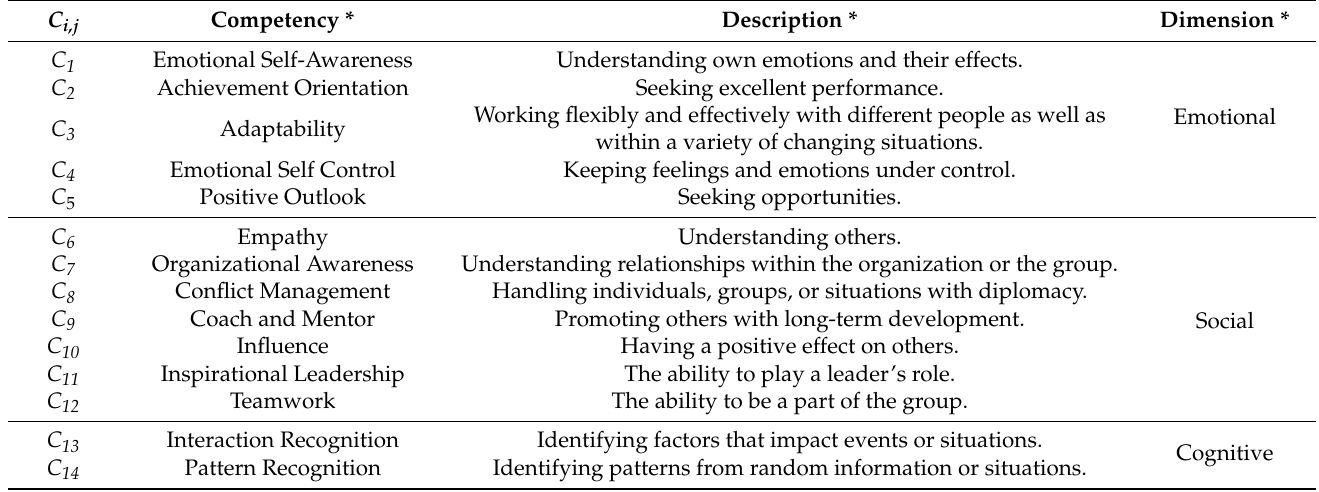
Table 1. Systems-Thinking-based leadership competencies, their pertaining descriptions, and